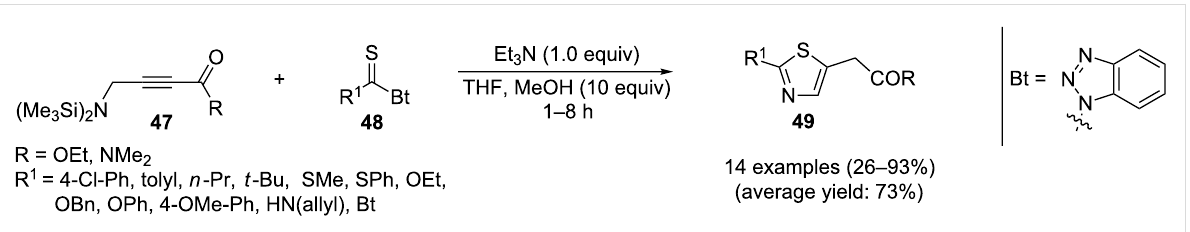
Scheme 13: Synthesis of thiazoles 49 by treatment of silyl-protected N -propargylamines 47 with benzotriazolylthiones 48 .